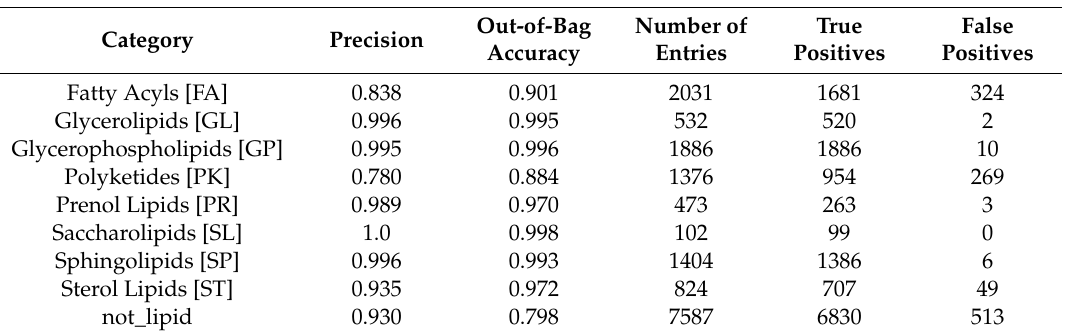
Table 1. LIPIDMAPS Structure Database (LMSD) + human metabolome database (HMDB)_non_lipid model performance (category).